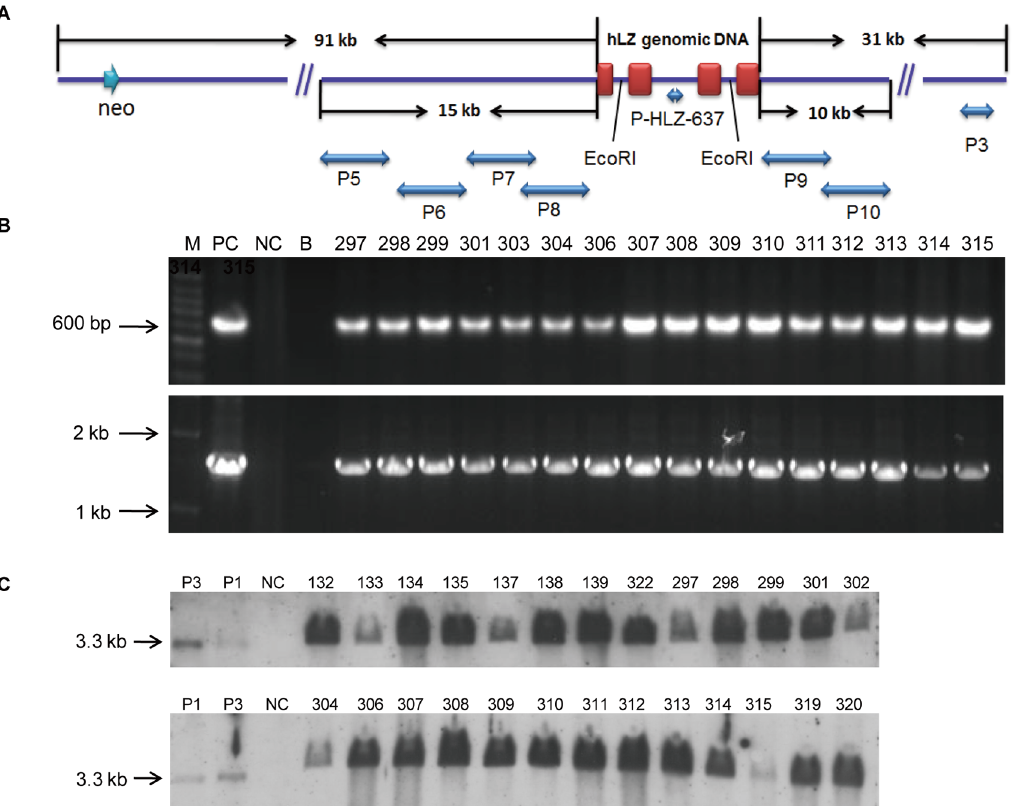
Fig 1. Production and identification of transgenic pigs. (A) Structure of expression vector pBAC-hLF-hLZ-Neo. It contains a 4.8-kb hLZ genomic DNA, 5 ’ and 3 ’ flanking region of the hLF gene and a selection cassette Neo. The lower bars represent the position of the PCR products from the primer pairs P5 – P10, which were used for verification of the intactness of the BAC vector.(B) Identification of transgenic pigs by PCR analysis. PC, positive control vector; NC, genomic DNA from three WT pigs; B, water; lane 5 – 20: genomic DNA from transgenic cloned pigs; M, 100-bp DNA ladder or 1-kb DNA ladder.(C) Identification of transgenic pigs by southern blot analysis. P1, plasmid vectors with one copy of the hLZ gene; P3, plasmid vectors with three copies of the hLZ gene; NC, genomic DNA from a WT